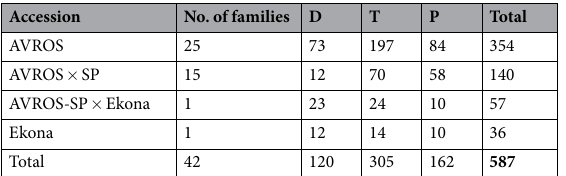
Table 1. The first validation set consists of three fruit forms belong to four paternal stocks. SP – Serdang fertile pisifera ; D – dura ; T – tenera ; P – pisifera .